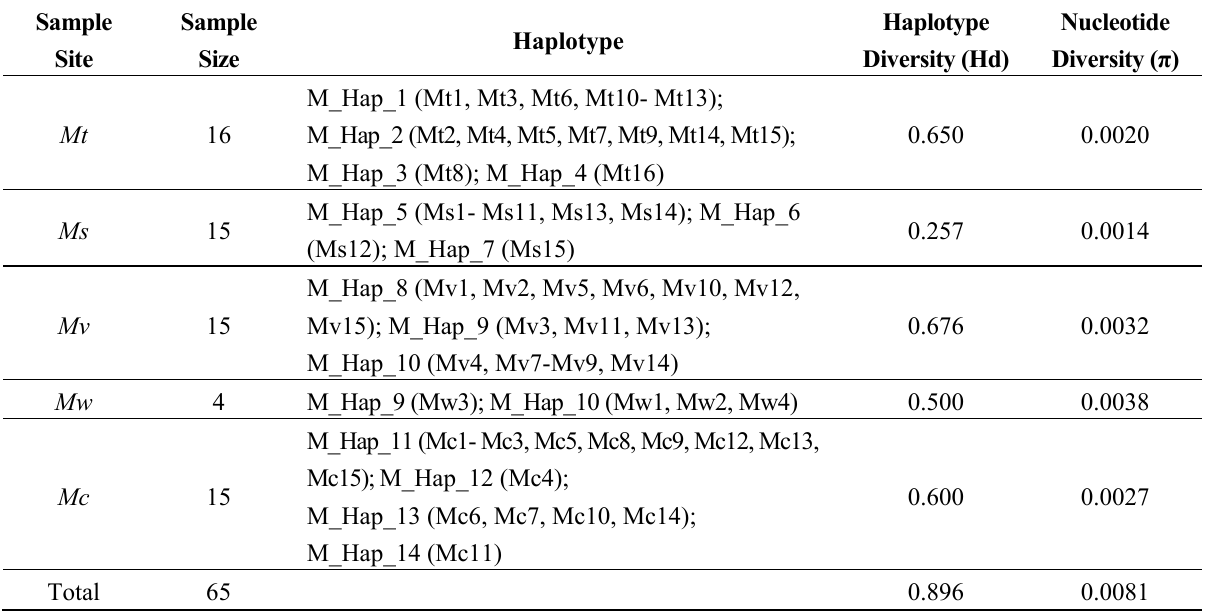
Table 4. Sample sites, sample sizes and haplotype distributions of Mongolodiaptomus birulai. Sample